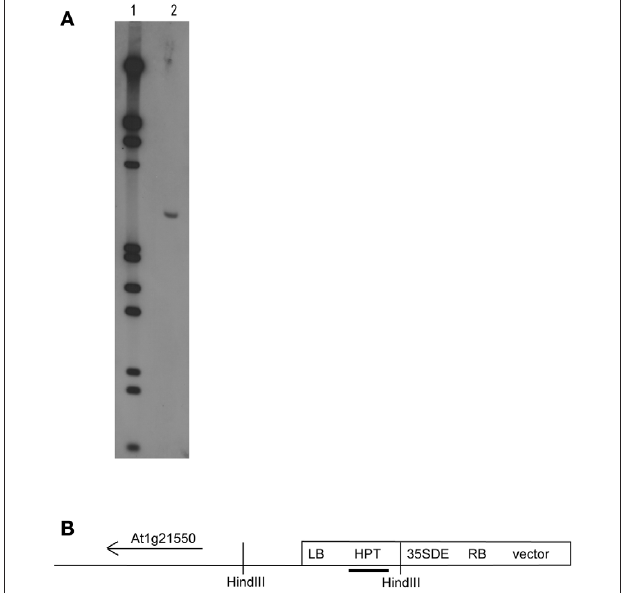
FIgURe 1 | Southern blot analysis of sns-D . (A) Plant DNA (5 μg) of the sns-D mutant (lane 2) was digested with Hin dIII and separated in 0.7% agarose gel along a dig-labeled Lambda Eco RI/ Hin dIII marker (lane 1), blotted and hybridized with a DIG-labeling hpt probe. (B) Schematic presentation of the sns-D Hin dIII fragment, which consists of the T-DNA region containing the left border (LB) and the flanking plant DNA close to the gene At1g21550. The hpt probe used to detect the Hin dIII fragment on the blot is shown as